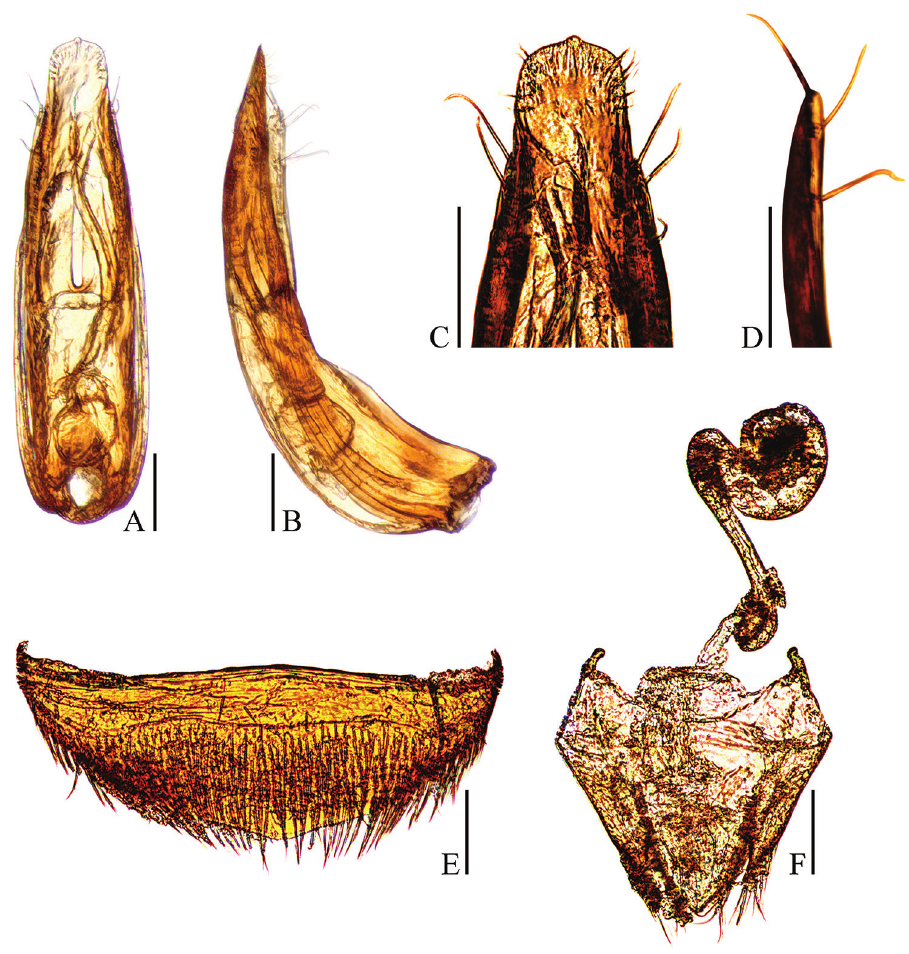
Figure 5. Ptomaphagus (s. str.) masumotoi Nishikawa, 2011 ( ♂ : paratype; ♀ : holotype). A aedeagus (dorsal view) B aedeagus (lateral view) C aedeagal apex (ventral view) D paramere apex (lateral view) E ventrite VIII ♀ (ventral view) F spermatheca, genital segment and ovipositor (ventral view). Scale bars: 0.1